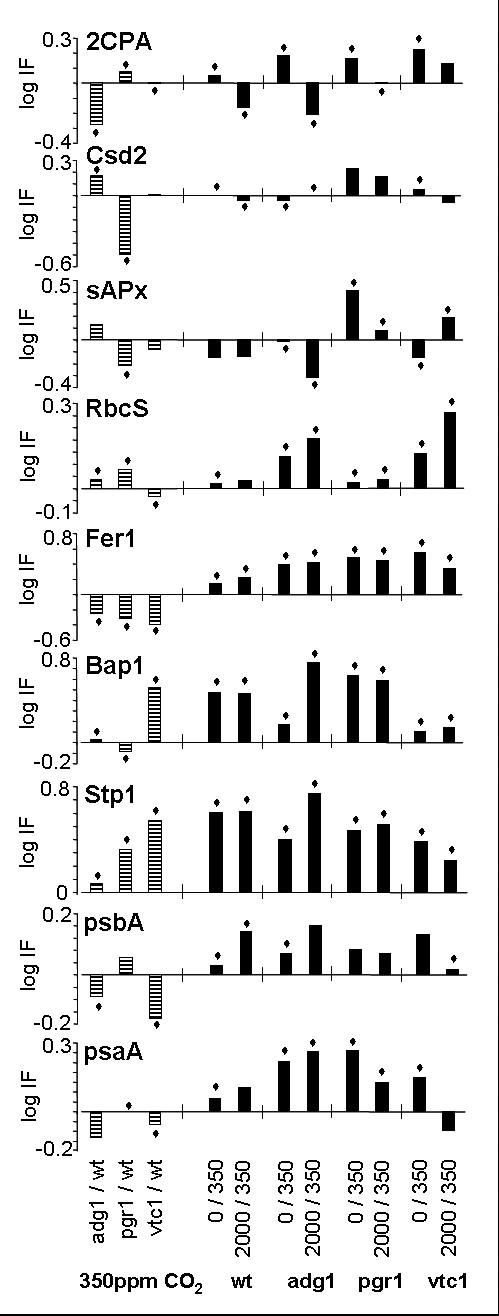
Semi-quantitative RT-PCR data of selected plastome and nuclear encoded genes. The PCR products were separated on ethidium bromide containing agarose gels and documented electronically in UV light and analyzed densitometrically. The values are given as the logarithm of the induction factor which is calculated from the ratio of transcript level of WT and mutants at ambient 350 CO2 (hatched bars). The black bars represent logarithmic values calculated after fumigation with 0 or 2000 ppm CO2, respectively, in relation to corresponding control at 350 ppm CO2 for wt, adg1, pgr1 and vtc1. The data are means of n = 3, (◆) indicates that the SD was less than 30% of the mean value.